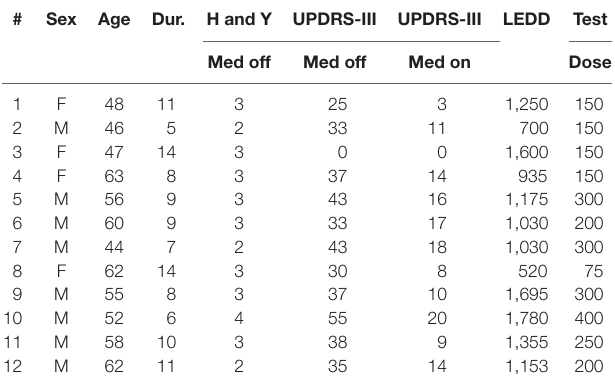
Table 1 | Patient demographic and medication